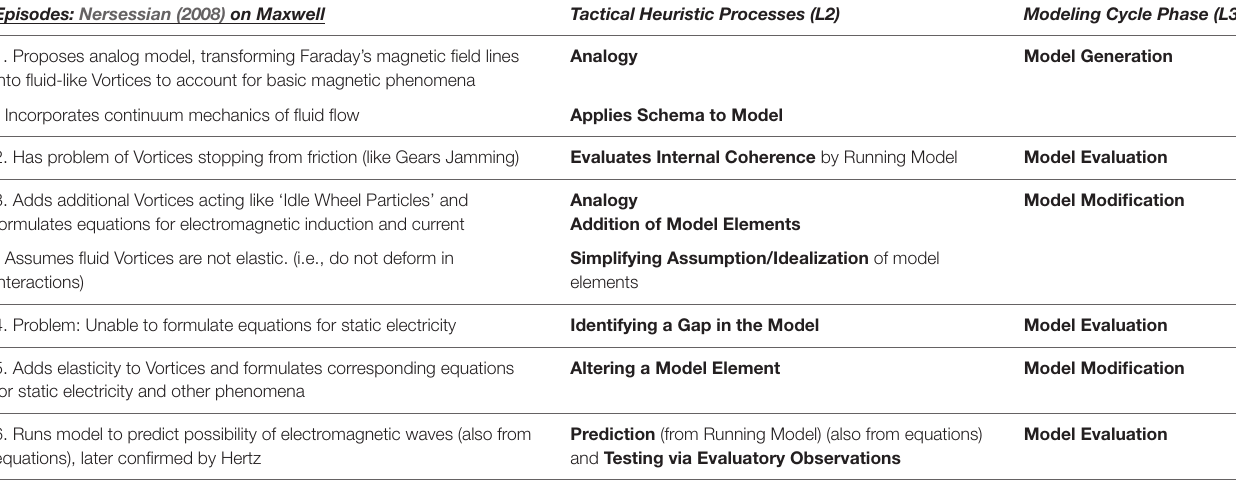
TABLE 3 | Examples of processes used in development of Maxwell’s theory of